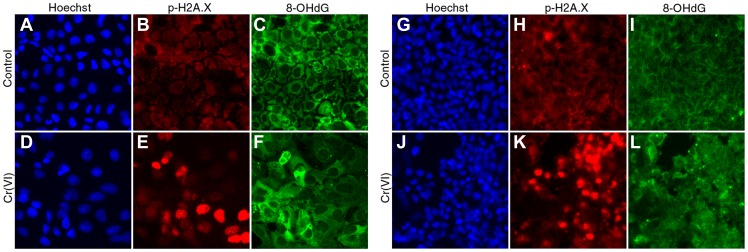
Representative images of 8-OHdG and γ-H2AX fluorescence in Caco-2.Representative images of 8-OHdG and γ-H2AX staining in control and 100 µM Cr(VI) treated undifferentiated (A–F) and differentiated (G–L) Caco-2 cells at 24 hr. All images were taken with the same magnification (20X). Intensity of 8-OHdG and γ-H2AX immunostaining was determined in nuclear area identified by staining with Hoechst 33342.